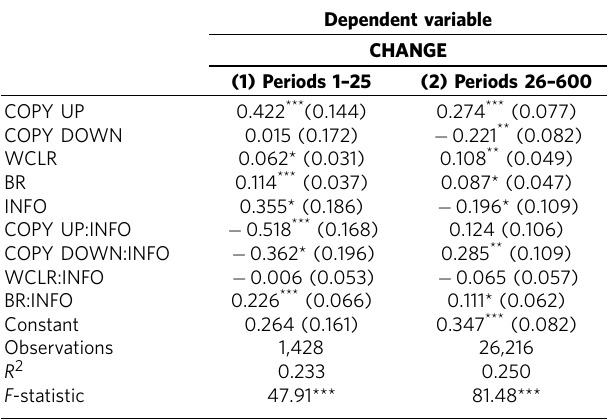
Figure 2 | Median actions. Up to period 25, each dot represents the median action in bins of 5 periods. From period 25 (dashed vertical line), on each dot represents the median action in bins of 25 periods. In the naive phase (periods 1–25), the average action (s.d. in parentheses) is 3.65 (1.58) in NoInfo and 3.37 (1.19) in Info. In the learning phase (periods 26–300), this changes to 2.22 (1.90) in NoInfo and 2.93 (1.65) in Info. Finally, in the long-run phase (periods 301–600), behaviour settles down at 1.23 (1.45) in NoInfo and 2.62 (1.80) in